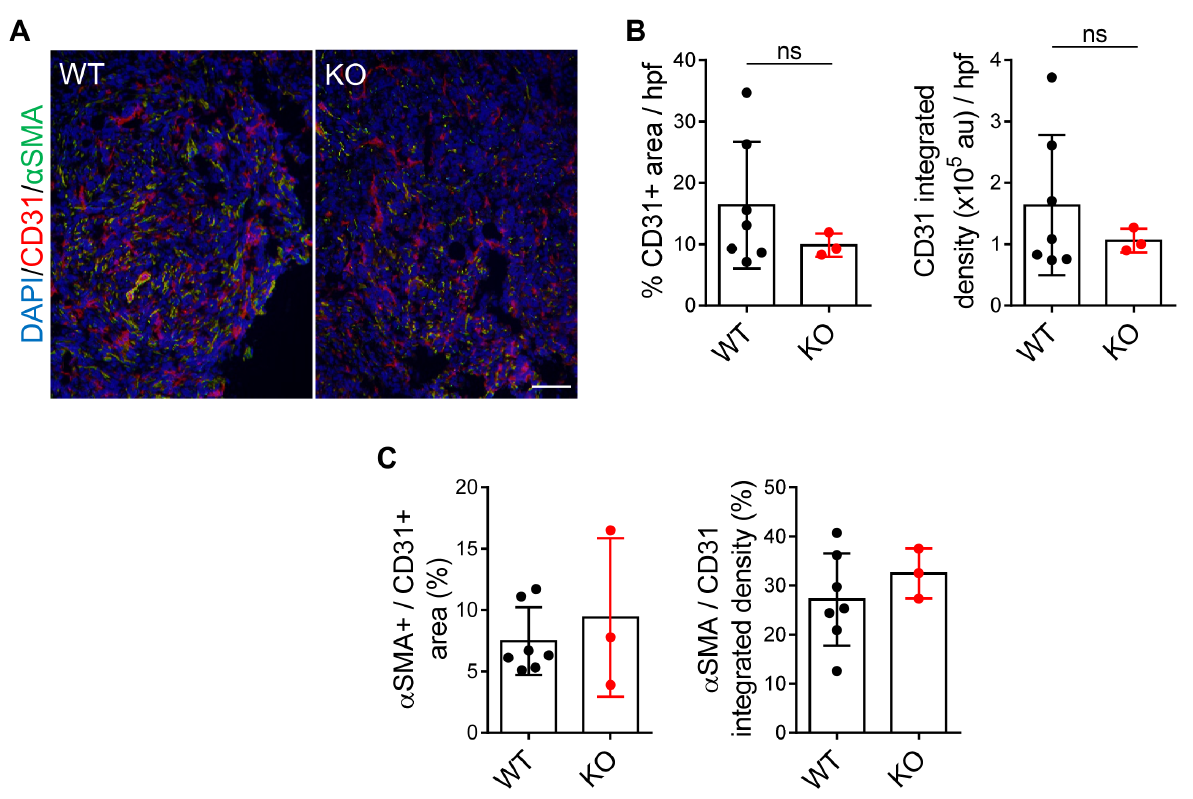
Figure 4. Tumor vascularity and pericyte coverage are not significantly different in ephrin-A1-deficient hosts. ( A ) Representative images of CD31 (red), α SMA (green), and DAPI (blue) staining on cryosections of 4T1 primary tumors harvested from WT and KO littermates at day 14 post-implantation. Scale bar: 100 µm. ( B ) Quantification of CD31+ area and integrated intensity in arbitrary units (au) per high power field (hpf) of view. ( C ) Quantification of α SMA colocalization with CD31 as a percentage of α SMA+ over CD31+ stained area and integrated density. Data shown are averages ± SD with each data point representing an individual mouse ( n =3–7 mice per